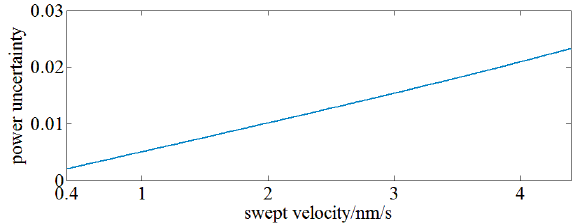
Figure 6. The relationship between power uncertainty and swept velocity of swept LO.